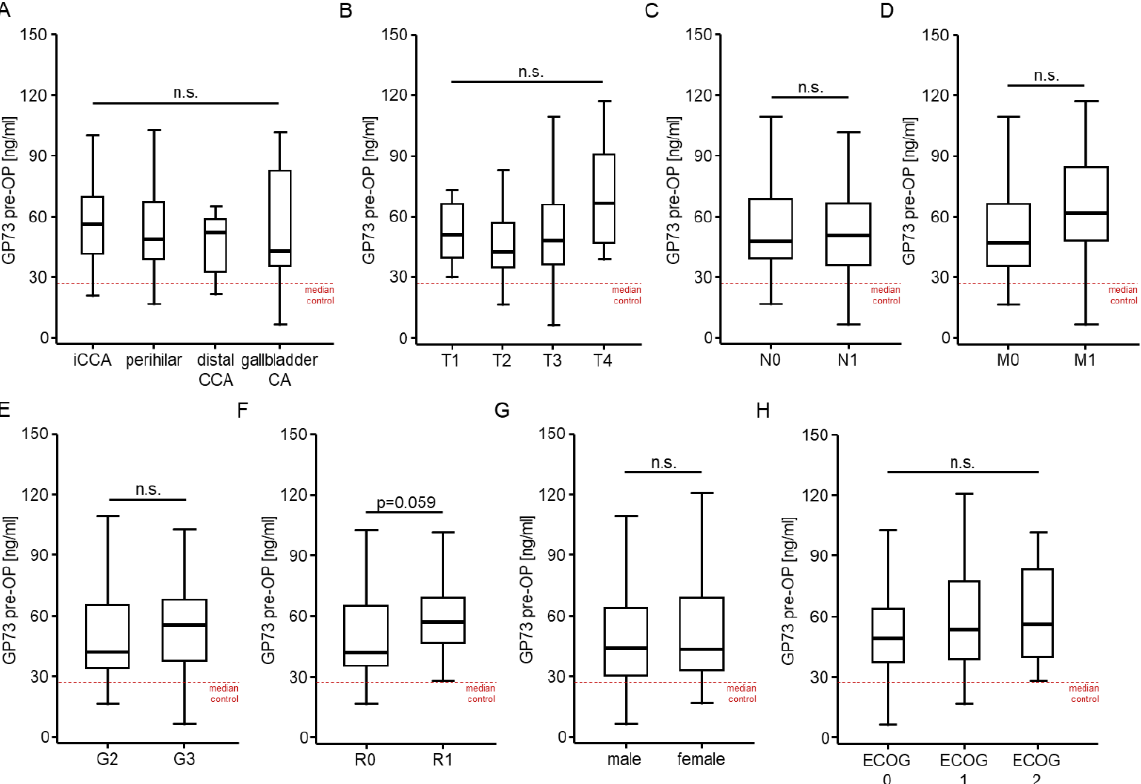
Figure 2. GP 73 serum levels are unaltered between different tumor and patient characteristics. Initial GP73 serum levels are unaltered between patients with different tumor localizations ( A ), different TNM-stages ( B – D ), and tumor grading ( E ). ( F ) Patients who were resected with microscopically remaining tumor cells (R1) show a trend towards higher baseline GP73 levels, though statistical significance is not reached. Serum GP73 levels are unaltered between male and female patients ( G ) as well as patients with different ECOG performance status ( H ).